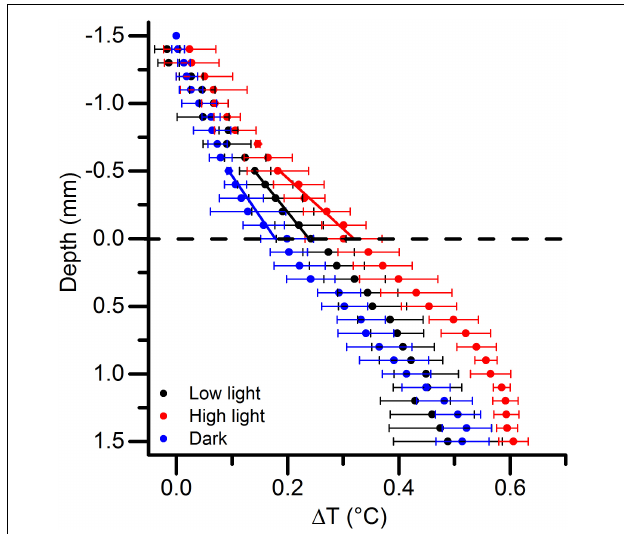
FIGURE 4 | Vertical microprofiles of temperature increase ( (cid:49) T in ◦ C) relative to the free-flowing water temperature under an incident photon irradiance of 1000 µ mol photons m − 2 s − 1 . The dashed line indicates the microbial mat surface. Black, red, and blue symbols represent measurements in a low light-, high light-, and dark-adapted mats, respectively. The straight black, red and blue lines indicate the linear regressions used to estimate the areal heat dissipation from the microbial mat. Data points with error bars represent means ± 1 SD ( n =